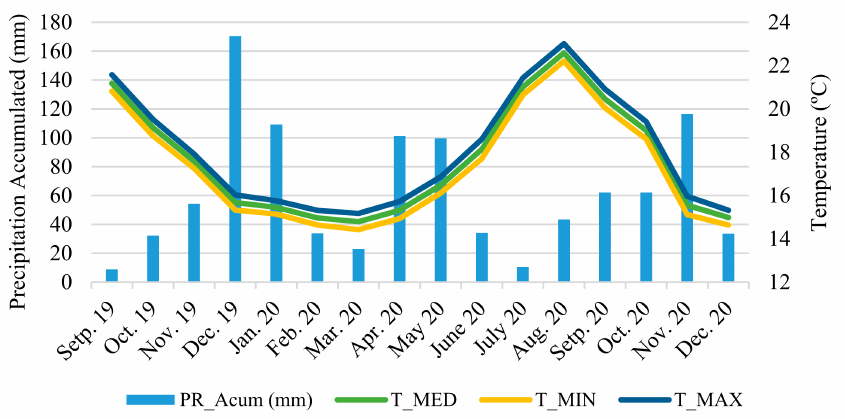
Figure 1. Climatic parameters for minimum, maximum and average temperature ( ◦ C), and accumu- lated precipitation